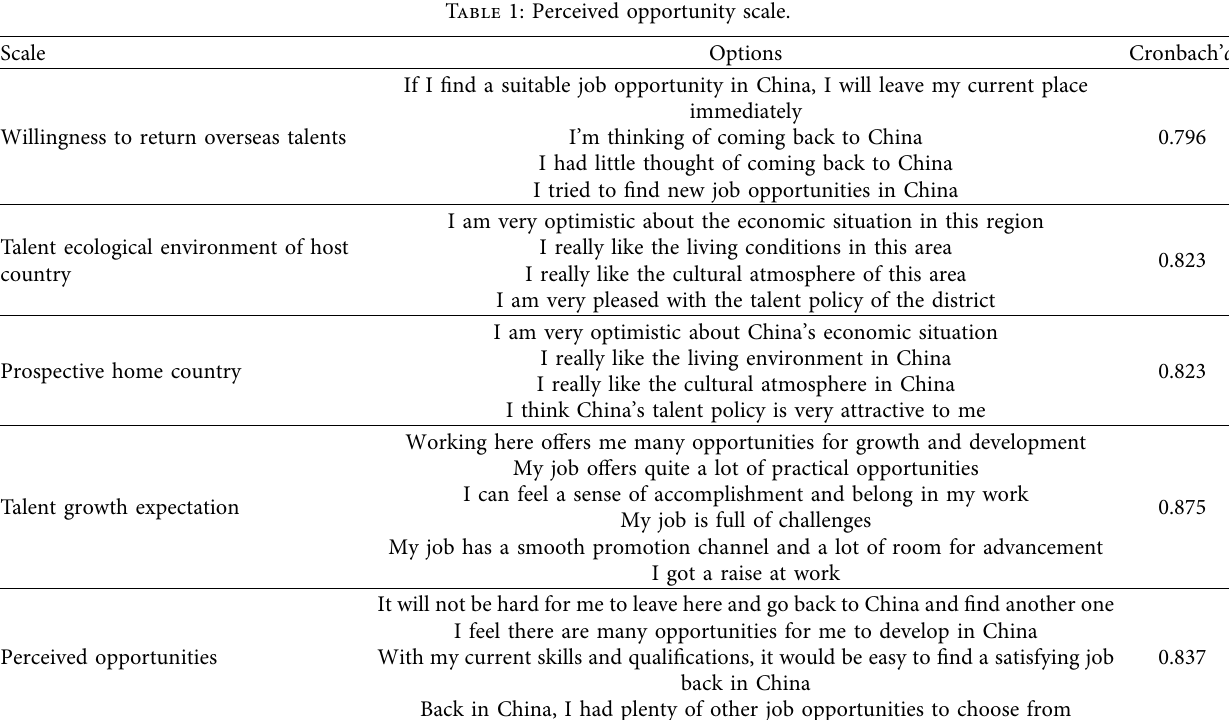
Figure 1: Correlativity model Table 1: Perceived opportunity scale.